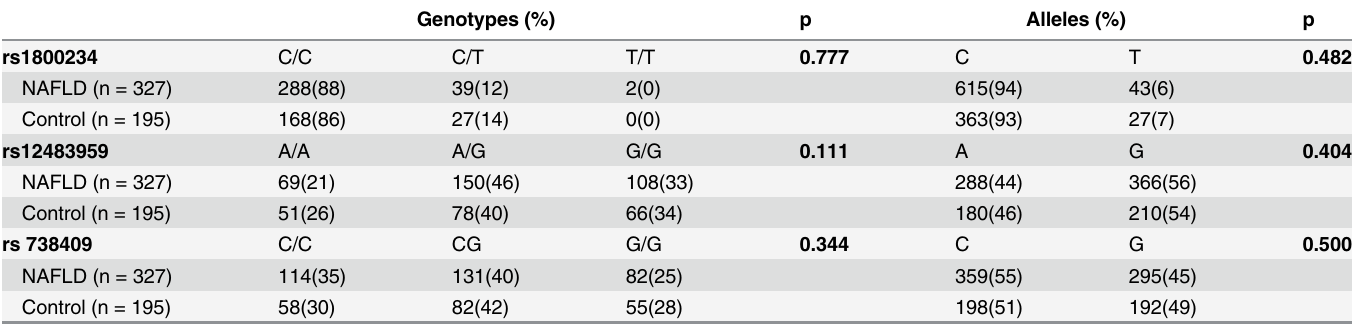
Table 3. The Genotypes and Allele Distribution of the PPARA rs1800234 and adiponutrin (rs12483959 and rs 738409) Gene Polymorphisms in Case (Type 2 DM with NAFLD) and Control Groups (Type 2 DM without